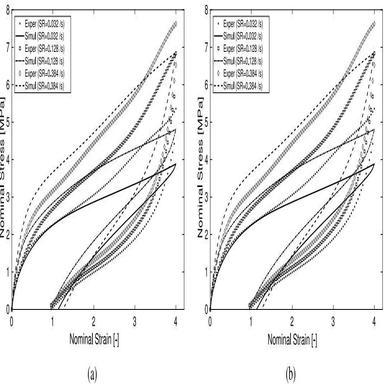
Viscous parameters identification with a loading–unloading cyclic data of 400% strain at strain rates of 0.384 /s, 0.128 /s, and 0.032 /s: (a) Model fitting with one Yeoh and four Neo–Hooke Maxwell elements, (b) model fitting with one Yeoh and five Neo–Hooke Maxwell elements with twelve viscous parameters (total fifteen parameters; three elastic and twelve viscous). The increase of the Maxwell elements higher than five does not enhance the model fitting quality with respect to experimental data.